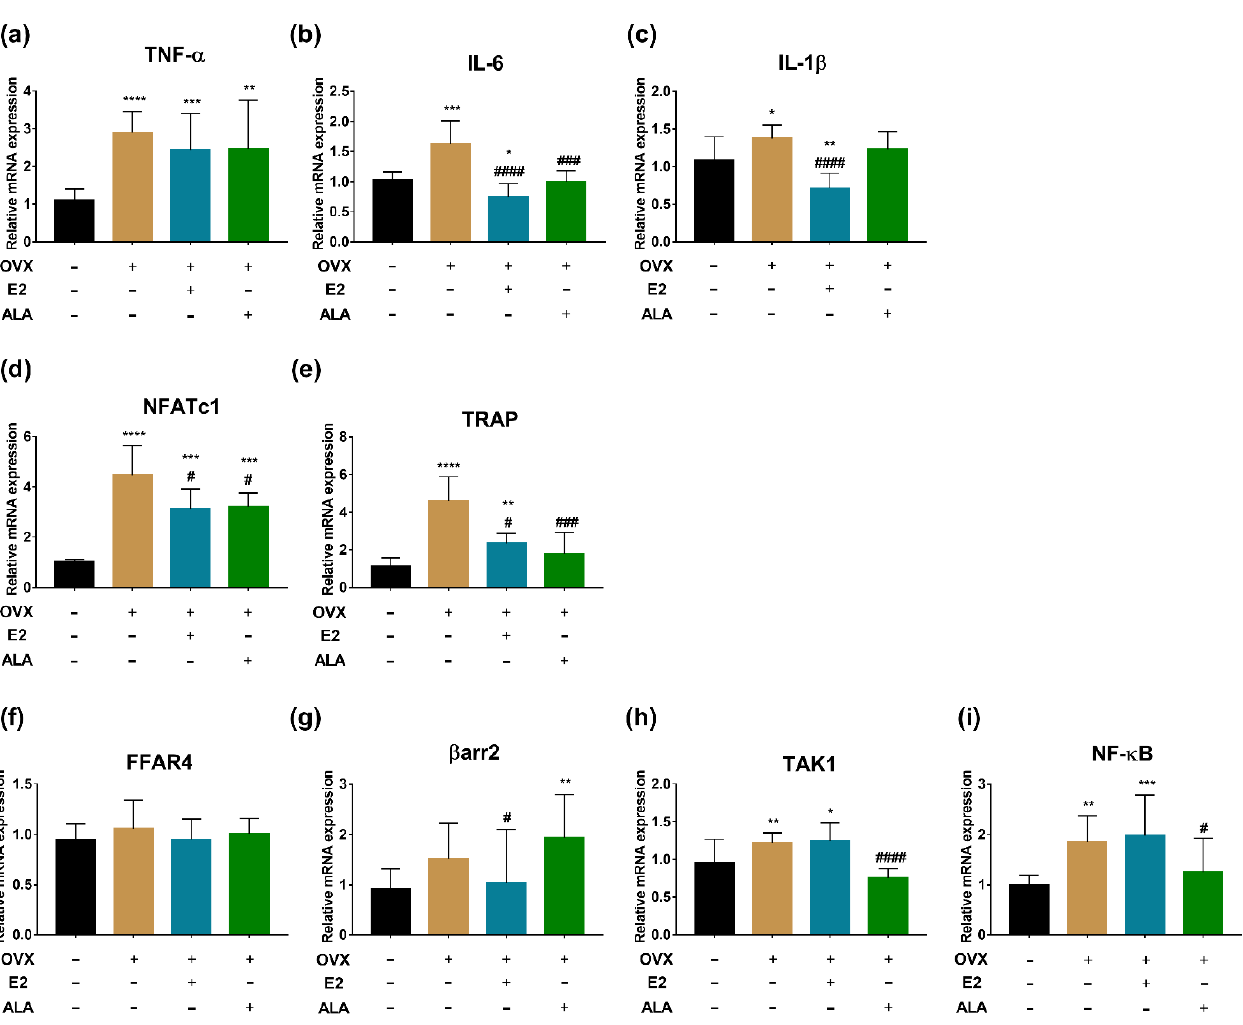
Figure 8. The expression of inflammatory factors and osteoclast genes in the bone of ovariectomized rats with ALA preventive treatment. ( a ) TNF- α, ( b ) IL-6, ( c ) IL- 1β, ( d ) NFATc1, ( e ) TRAP, ( f ) FFAR4, ( g ) βarr2, ( h ) TAK1 and ( i ) NF- κ B expression were measured by RT-qPCR. * p < 0.05, ** p < 0.01, *** p < 0.001, **** p < 0.0001 vs. the SHAM group (OVX (−), E2 (−), ALA (−)). # p < 0.05, ### p < 0.001, #### p < 0.0001 vs. the OVX group (OVX (+), E2 (−), ALA (−)).